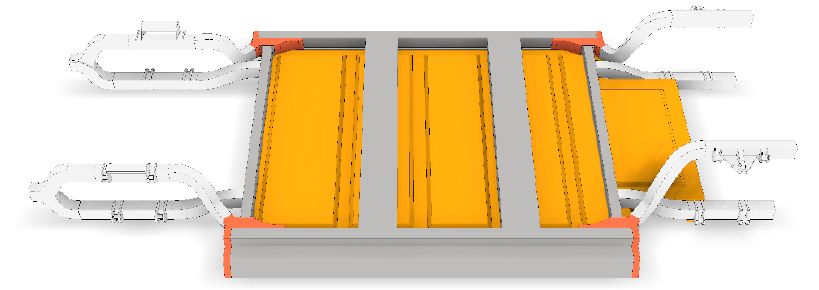
Figure 13. Vehicle chassis with colours corresponding to different manufacturing techniques: castings in red, extrusions in grey, hydro-formed metal in white and sheets in orange.